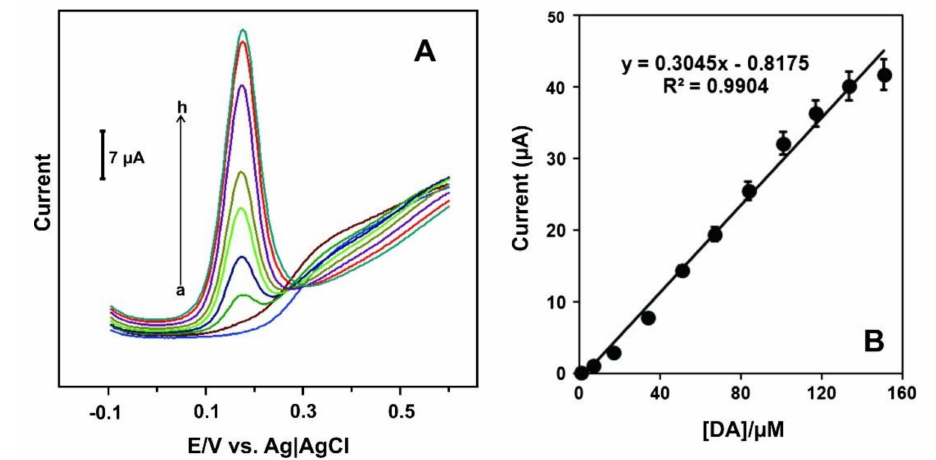
Figure 6. ( A ) DPV signals of C 60 / PdNPs-SPCE in the absence (curve a) and presence of DA at concentrations levels of 0.35 to 150.55 µ M (curves b-h); ( B ) The calibration curve. Reprinted from [145] with permission of